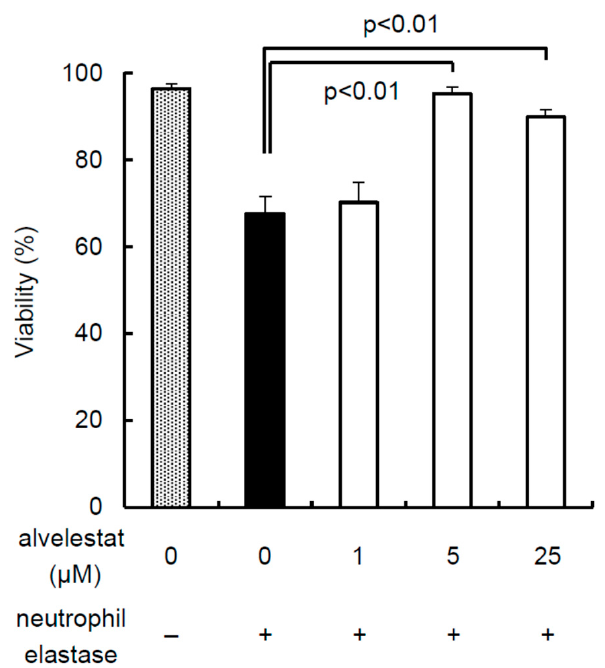
Figure 1. Inhibitory effect of alvelestat against the cytotoxicity of neutrophil elastase. Isolated porcine islets were cultured with or without 1 µ g/mL neutrophil elastase and 0–25 µ M alvelestat for 24 h. The islets were evaluated using double fluorescein diacetate/propidium iodide (FDA/PI) staining.